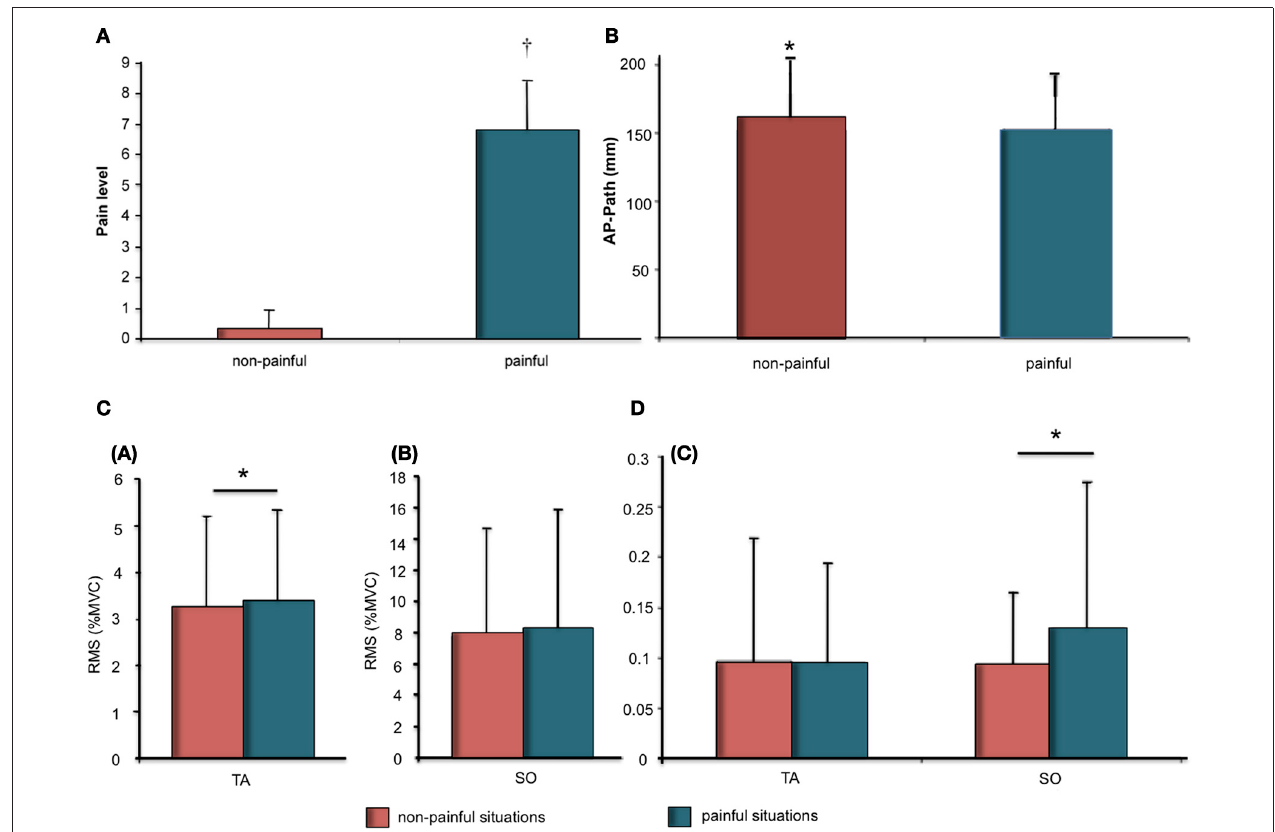
muscles. (a) RMS as % of MVC for TA as a function of stimuli (painful vs. non-painful). (b) RMS as % of MVC for SO as a function of stimuli (painful vs. non-painful); (D) (c) Variability of RMS as a function of stimuli (painful vs. non-painful). Significant differences are indicated as: ∗ p < 0 . 05.